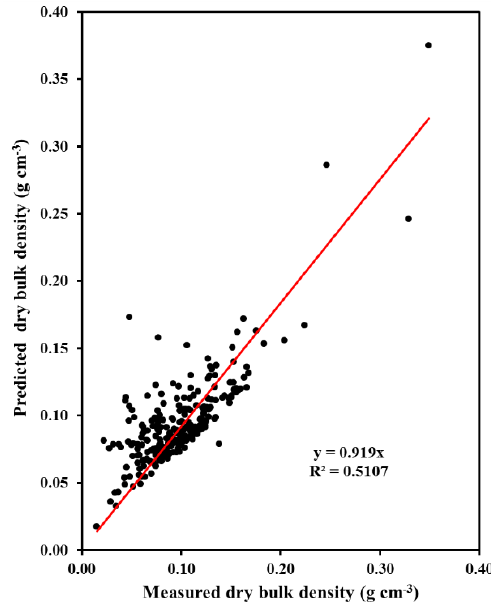
Figure A6. Regression of predicted dry bulk density on measured dry bulk density for a set of Indonesian oil palm plantation peats, omitting samples taken at depths less than 100 cm. Standard error of observations = 0.0238, P <